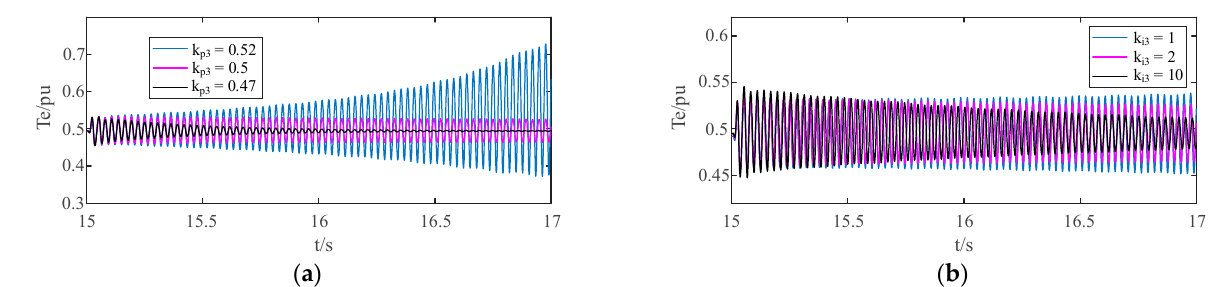
Figure 11. Electromagnetic torque in different RSC inner-loop proportional and integral coefficients: ( a ) different k p3 ; ( b ) different k i3 .